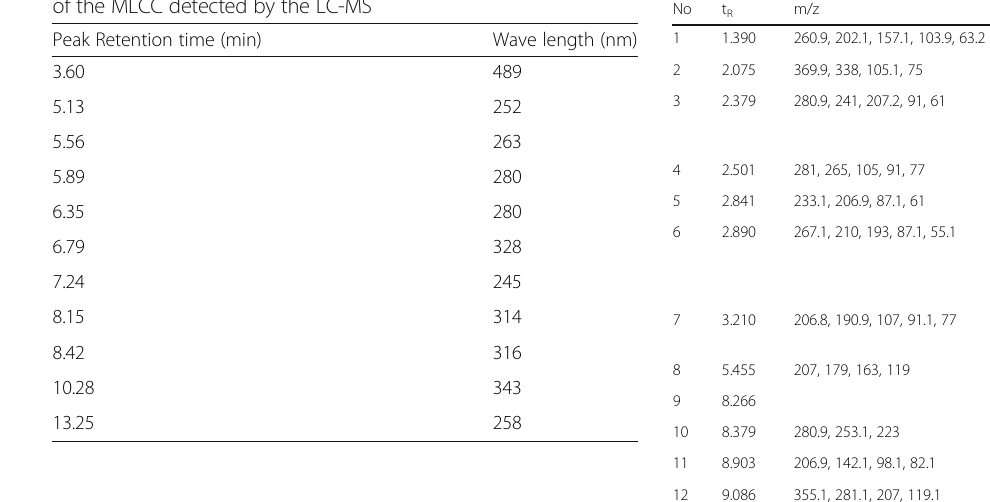
Table 2 Chemical compounds of the MLCC identified from